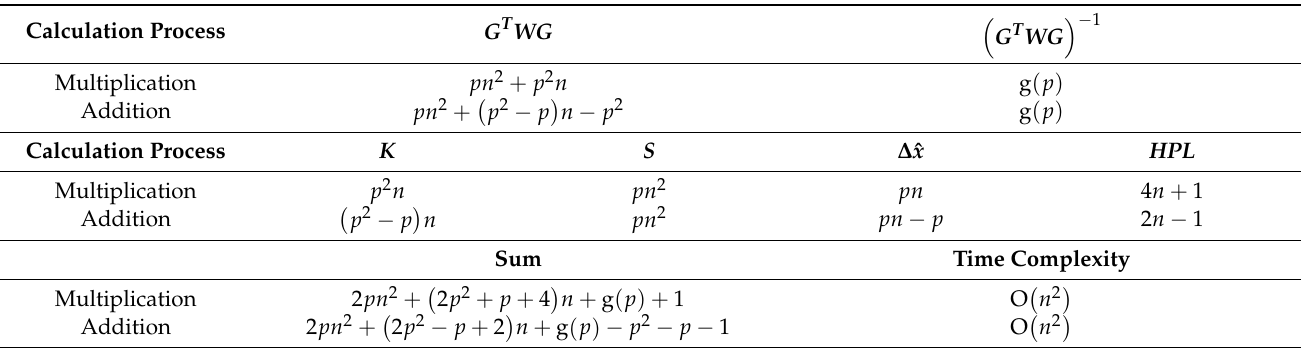
Table 2. Amount of calculation for the weighted least-squares RAIM